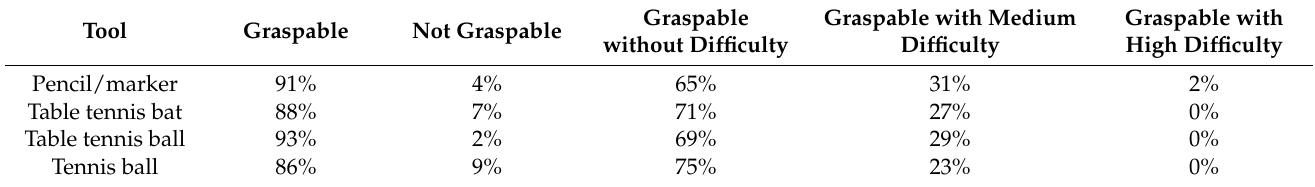
Table 2. Percentage of children with neurological impairments able or not in grasping a pencil/marker, table tennis bat, table tennis ball, and tennis ball. Without difficulty corresponds to score 1 in the 5-point Likert scale, high difficulty to score 5, and medium difficulty to scores 2, 3, and 4. The percentage sums are not 100% because not all the parents answered the questions.